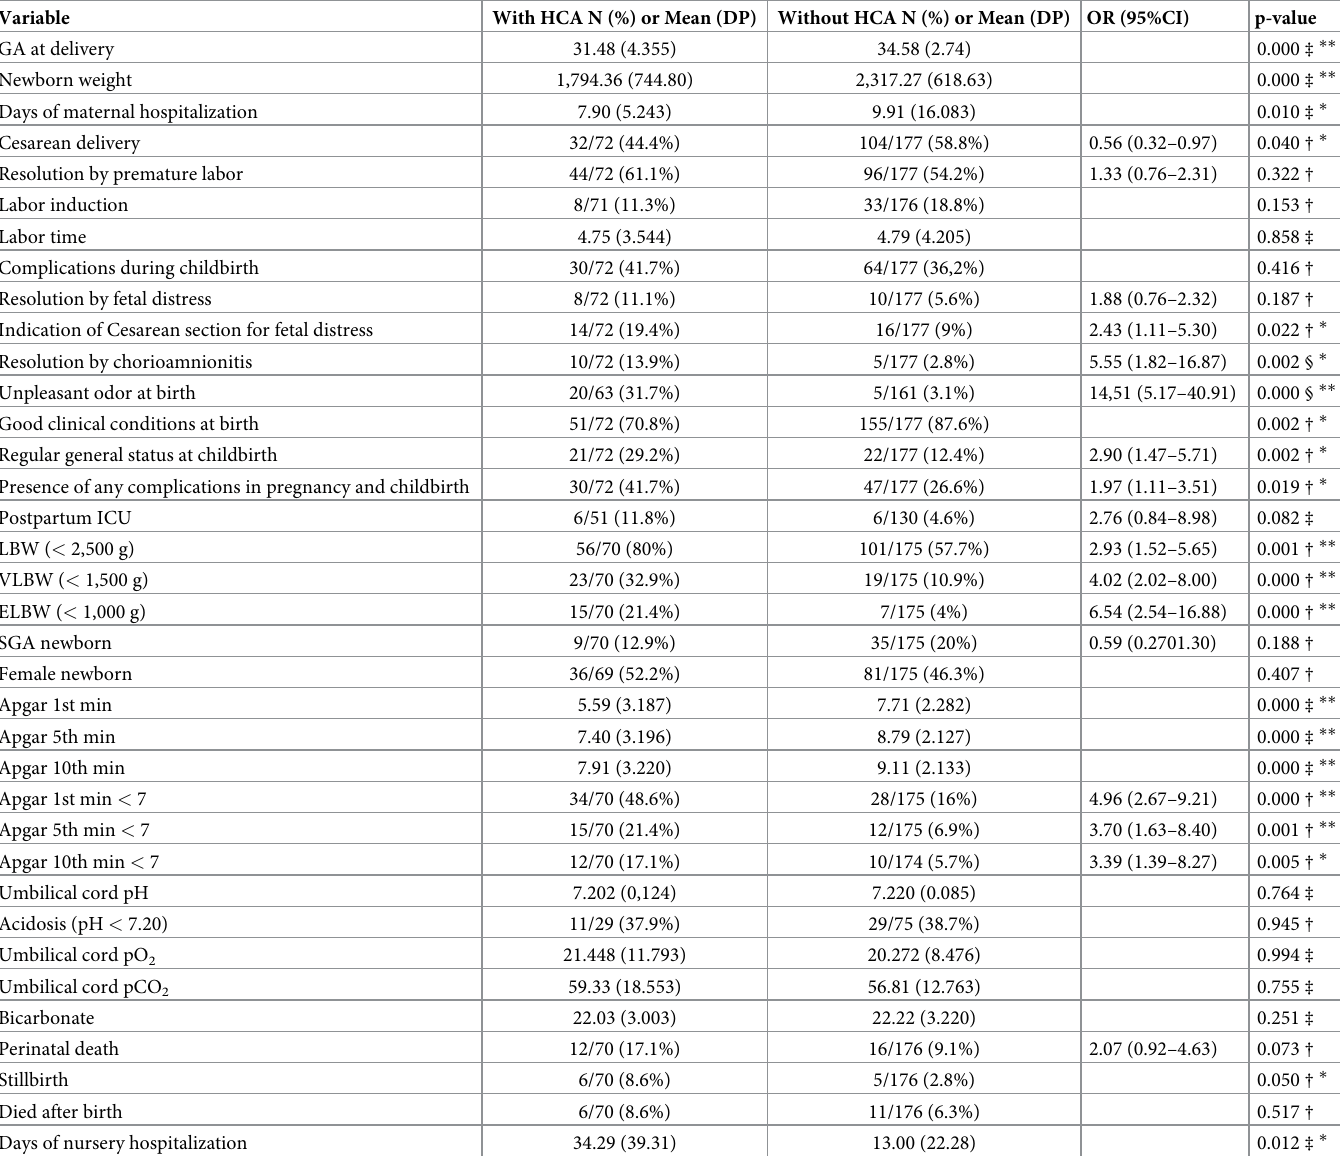
Table 3. Childbirth, newborn, and postpartum progression data of 295 women with PPROM, according to the presence or absence of HCA.